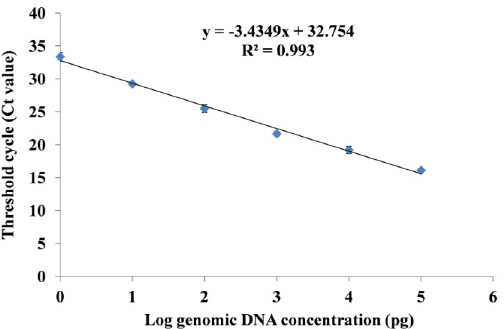
Figure 7. Standard curve of 10-fold serially diluted DNA of Fox R1 (100 ng − 1 fg) for the quantification of Fox R1 in infected roots and corms.